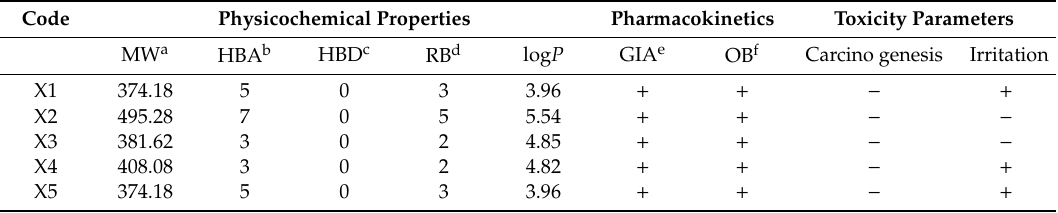
Table 3. Pharmaceutical prediction of in silico ADMET